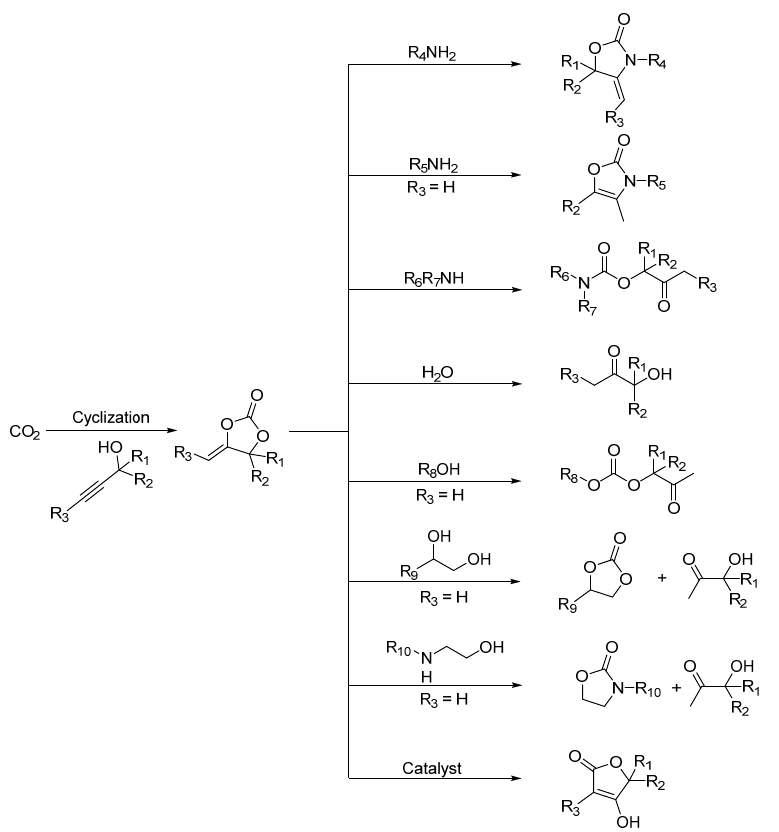
Figure 1. Schematic diagram of several routes for CO 2